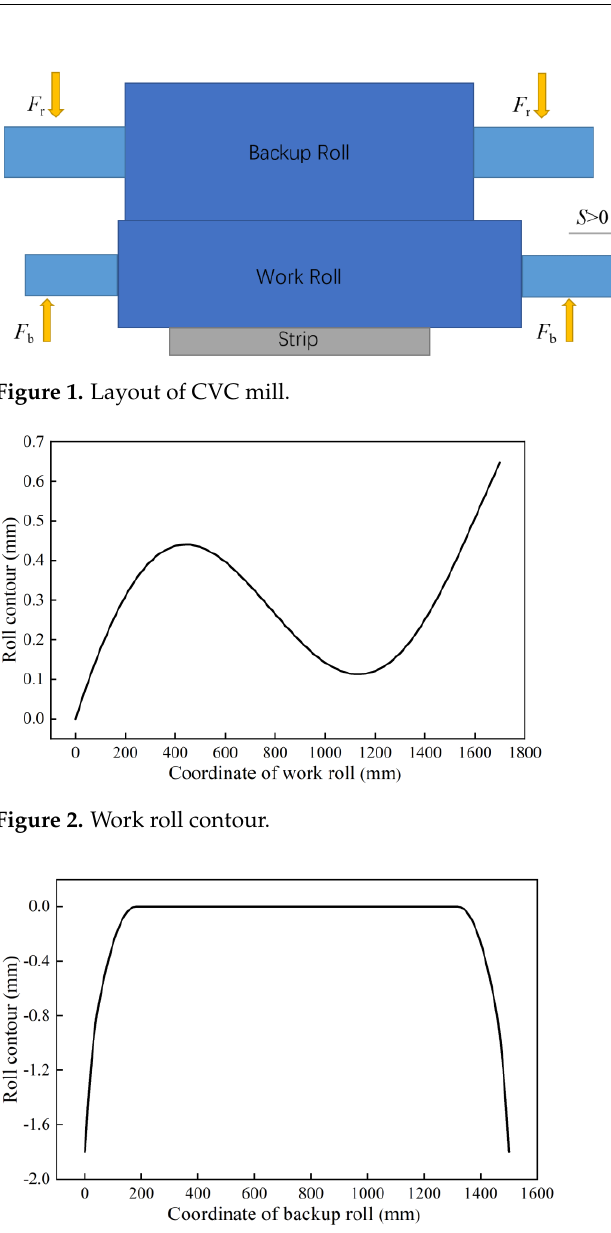
Figure 3. Backup roll contour.